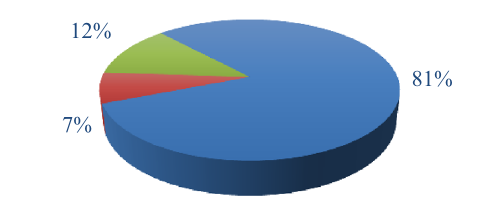
Fig. 4 Domestication status of medicinal and aromatic plants used for traditional oral